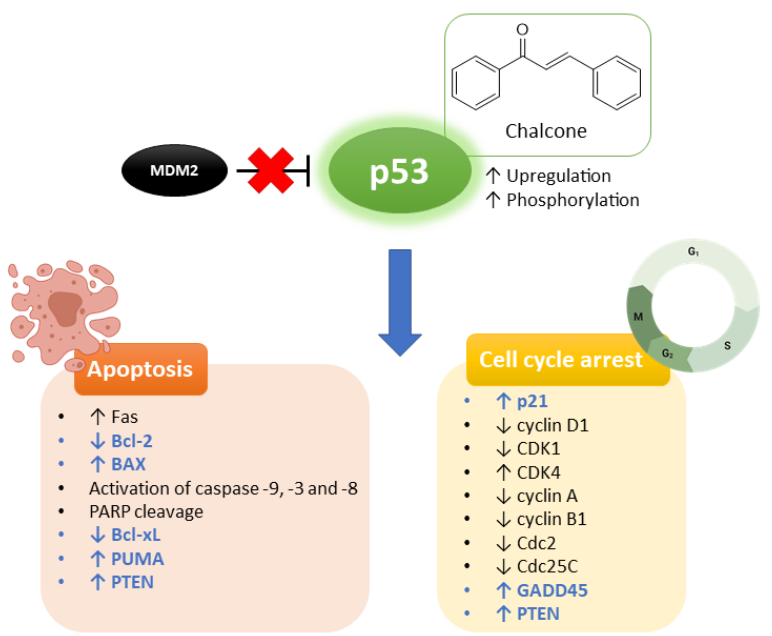
Figure 9. Interference of chalcones with p53 pathway. Chalcones are able to induce changes in the expression levels of several players, ultimately resulting in apoptosis and/or cell cycle arrest. These players can be direct targets of p53 (represented in blue) or indirect targets (represented in black).